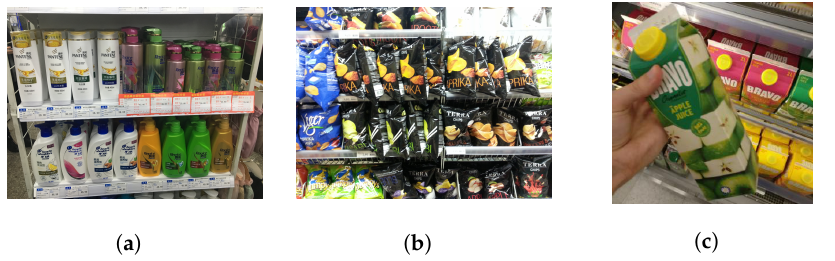
Figure 4. Image examples of a set of publicly available datasets: ( a ) CAPG dataset [44]; ( b ) GroZi 3.2k dataset [45]; ( c ) GroceryStore dataset